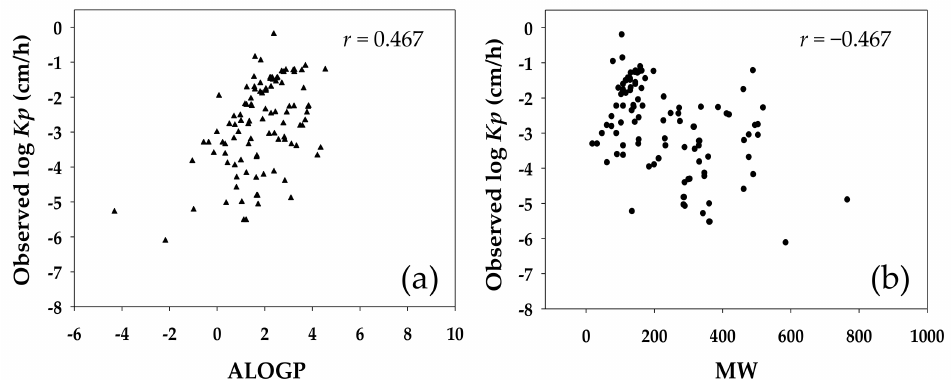
Figure 3. Distribution of experimentally observed logarithmic skin permeability (observed log Kp ) against ( a ) Ghose-Crippen octanol-water partition coefficient (ALOGP) and ( b ) molecular weight (MW) for 106 compounds included in model training and validation datasets. The r value is Pearson product-moment correlation coefficient and describes linear dependence of observed log Kp to targeted